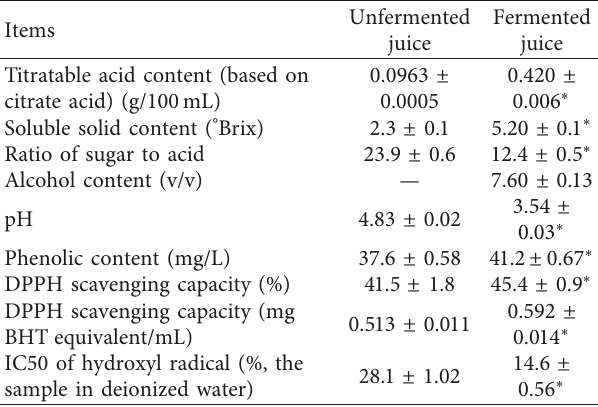
Table 1: Characterization of the unfermented and fermented juice.